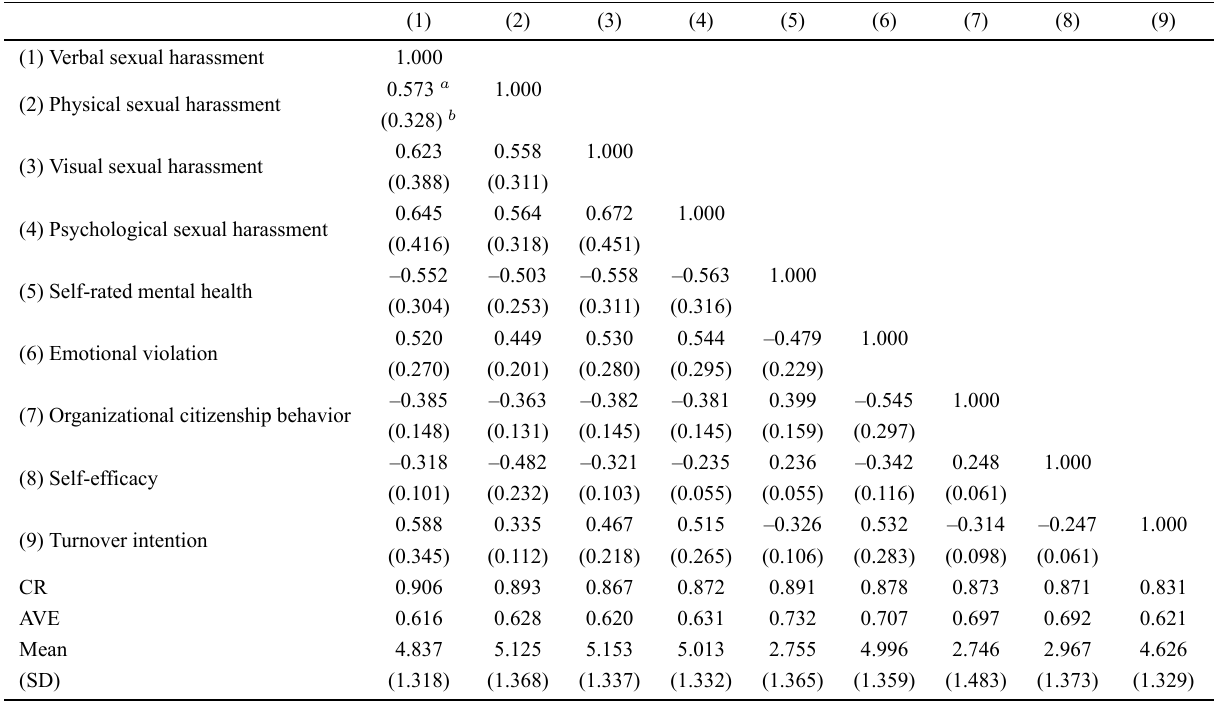
Table 3. Cronbach’s α reliability and